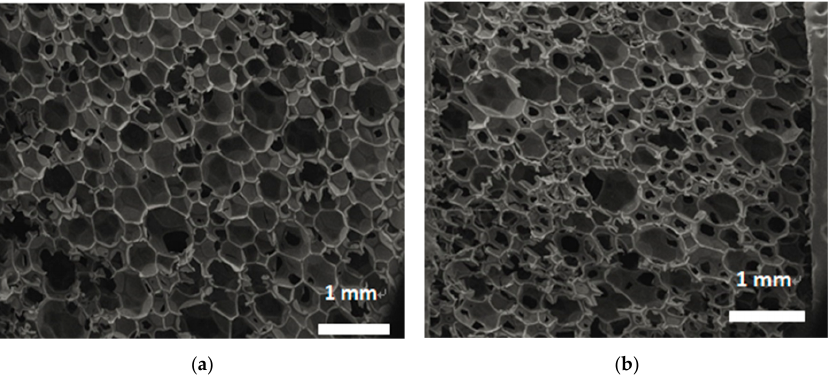
Figure 4. Changes in the rigid polyurethane foam from dry–humidity cycling: ( a ) initial sample, and ( b ) after 112 days of dry–humidity cycling.